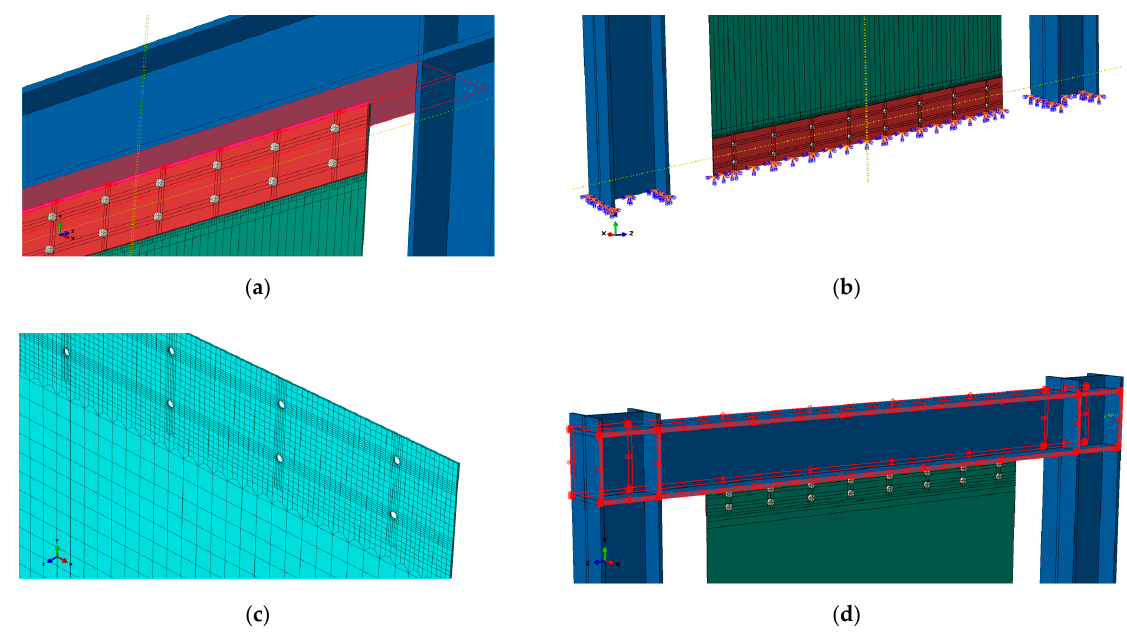
Figure 8. Construction details of the models used for performance analysis: ( a ) upper part of the bolt connection of the steel plate; ( b ) lower part of the bolt connection of the steel plate; ( c ) transitional meshes of the steel plate; ( d ) out-of-plane constraints for frame beams. Table 7. Cyclic loading mechanism. Table 6. FEM models used for performance analysis.